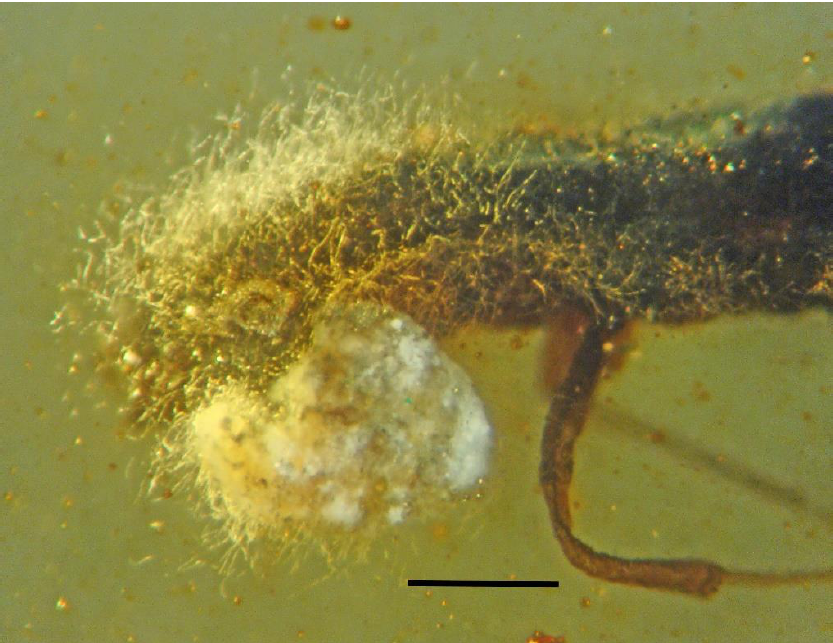
Figure 22. The platypodine, Palaeotylus femoralis (Coleoptera: Curculionidae: Platypodinae) covered with mycelium, conidiophores and conidia of the ambrosia fungus, Paleoambrosia entomophila (Ophiostomatales: Ophiostomataceae) in Burmese amber. Scale bar = 430 µm.